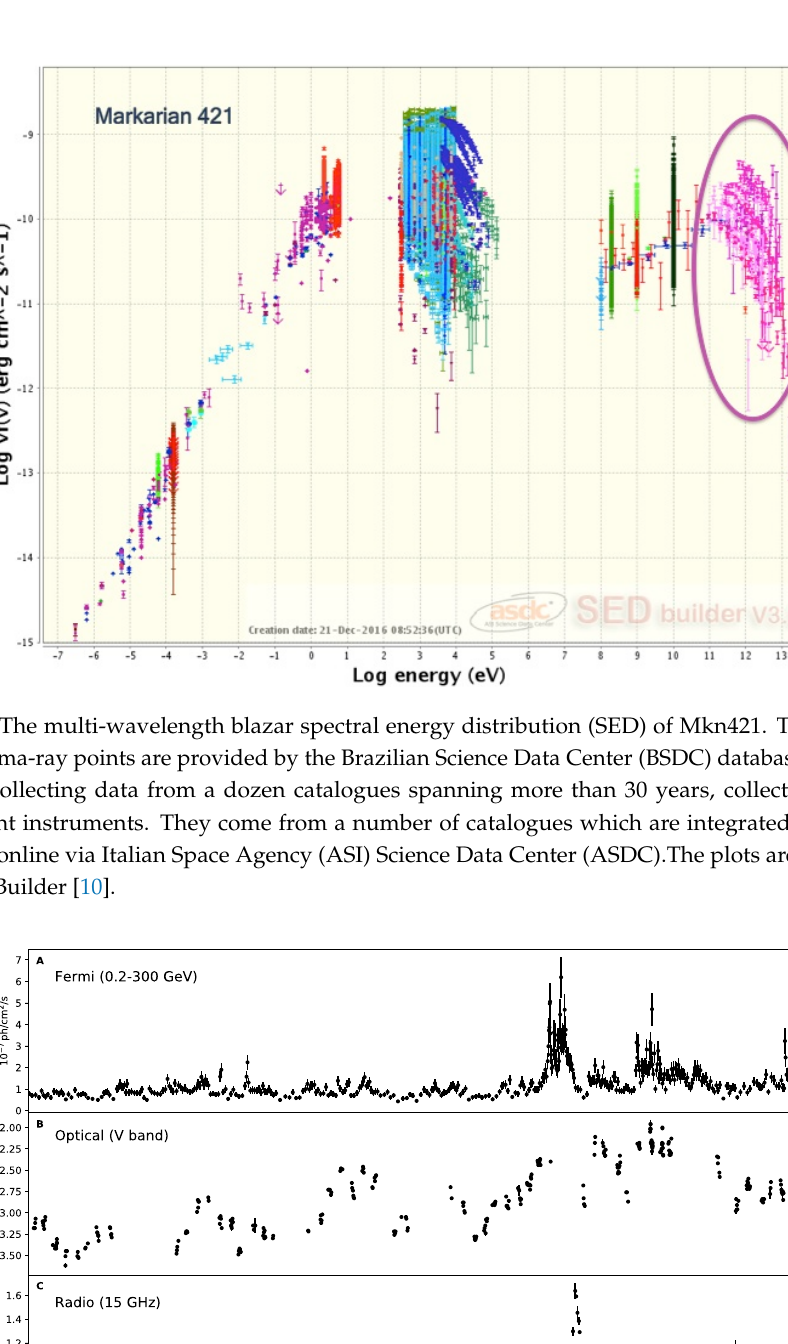
Fig. 1. Example of a data set. (Top panel) The spectral energy distribution (SED) for the pro- totypical blazar Mkn 421, plotted in the traditional energy flux representation ( ⌫F ⌫ vs. ⌫ ), and showing the extent of the source’s emission from radio to TeV gamma-rays. The marked VHE gamma-ray points are provided by the BSDC database. (Bottom panel) The ligth-curve of Mkn 421, with data collected since 1980, showing the presence of variability in all timescales, from decades to days. The plots are made up of data from a dozen catalogues spanning more than 30 years, and collected by over 10 di↵erent instruments. The plots are produced with the SEDBuilder tool available online from ASDC. 9 Figure 2. A long-term, multi-wavelength light-curve of Mkn421, showing 6 years of continuous coverage, from 2008 to 2014. The presence of intense variability in all timescales, from years to Figure 1.  -rays, (panel A), optical (panel B) and radio (panel C) light curves for Mkn421 from 2008 to days, is apparent. The OVRO data was collected using the online database provided by ASDC [10]; 2014. the Fermi gamma-ray data, which was analysed by us using an adaptive binning algorithm; the Steward Observatory optical data was directly obtained from the observatory’s online